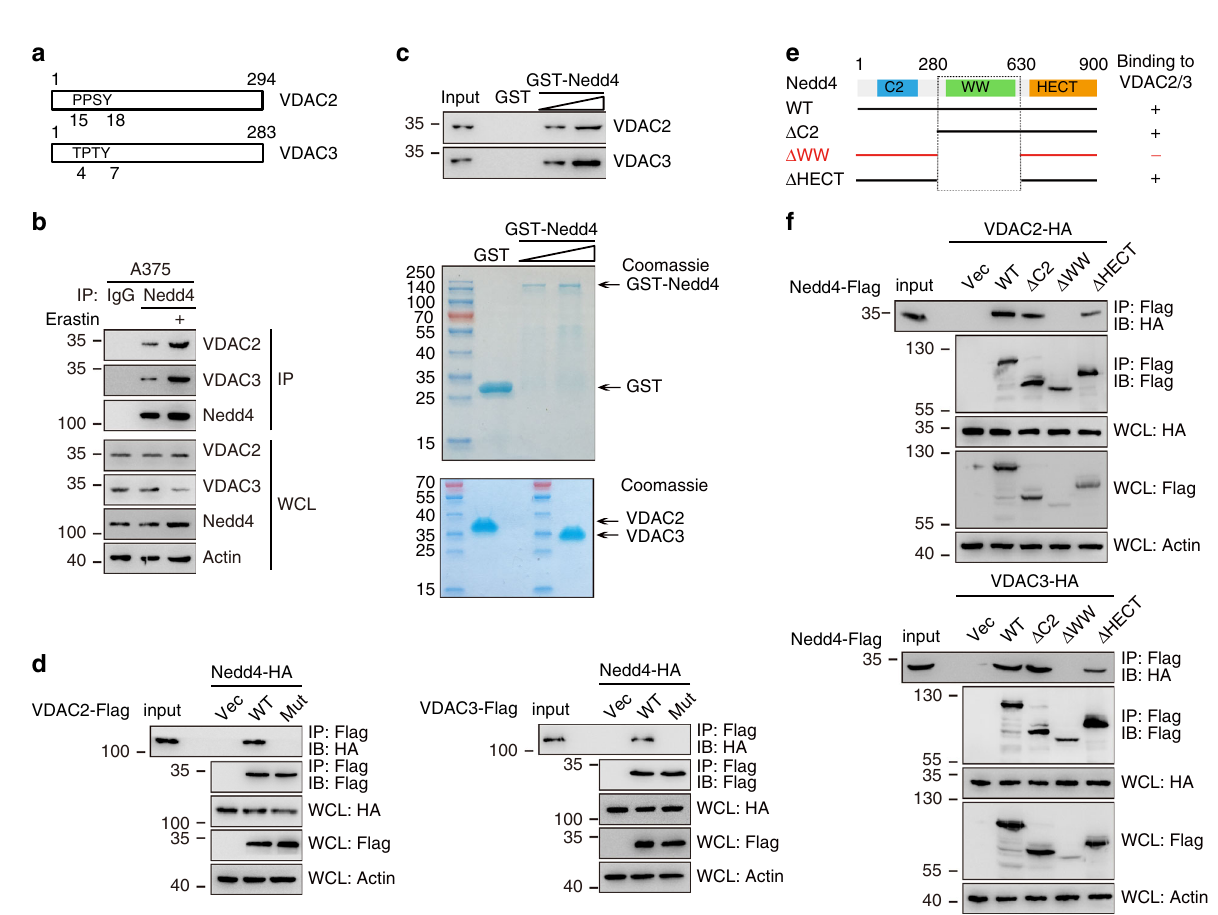
Fig. 2 Identi fi cation of Nedd4 as a VDAC2/3 interacting protein. a The PPxY motifs of VDAC2 (PPSY) and VDAC3 (TPxY) are conserved among different species. See also Fig. S2A, B. b Interaction between endogenous VDAC2, VDAC3, and Nedd4 under basal condition and erastin treatment. A375 cells were treated with DMSO or erastin (5 µ M) for 4 h, then MG132 (50 mM) was added into the culture medium for an additional 4 h. Whole-cell lysates (WCL) were used for IP with control serum (IgG) or anti-Nedd4 antibody, followed by immunoblotting (IB) with the indicated antibodies. c Nedd4 directly interacts with VDAC2/3 in vitro. Puri fi ed GST (control) or increasing amount of GST-Nedd4 were mixed with VDAC2 or VDAC3 and subjected to GST- pulldown followed by IB for VDAC2 or VDAC3. Ef fi cient VDAC2/VDAC3-Nedd4 interaction was detected in a dose-dependent manner. Coomassie blue stains show the input of each puri fi ed proteins used for binding. d The PPxY mutants of VDAC2 and VDAC3 are defective in Nedd4 binding. A375 cells were transfected with indicated DNA constructs for 48 h and treated with MG132 (50 mM) for 4 h. WCL were immunoprecipitated with anti-Flag followed by IB with anti-HA. e Schematic representation of WT Nedd4 and its deletion mutants, and summary of their interactions with VDAC2/3. Plus indicates strong binding; minus indicates no binding. f The WW domain of Nedd4 is essential for interaction with VDAC2/3. HA-VDAC2 or HA-VDAC3 was cotransfected with various Flag-Nedd4 deletion mutants in HEK293T cells. At 24 h post transfection, cells were treated with 50 mM MG132 for 4 h. WCL were subjected to immunoprecipitation with an anti-Flag antibody, followed by IB with anti-Flag or anti-HA. WCL were also used for IB with the indicated antibodies to show